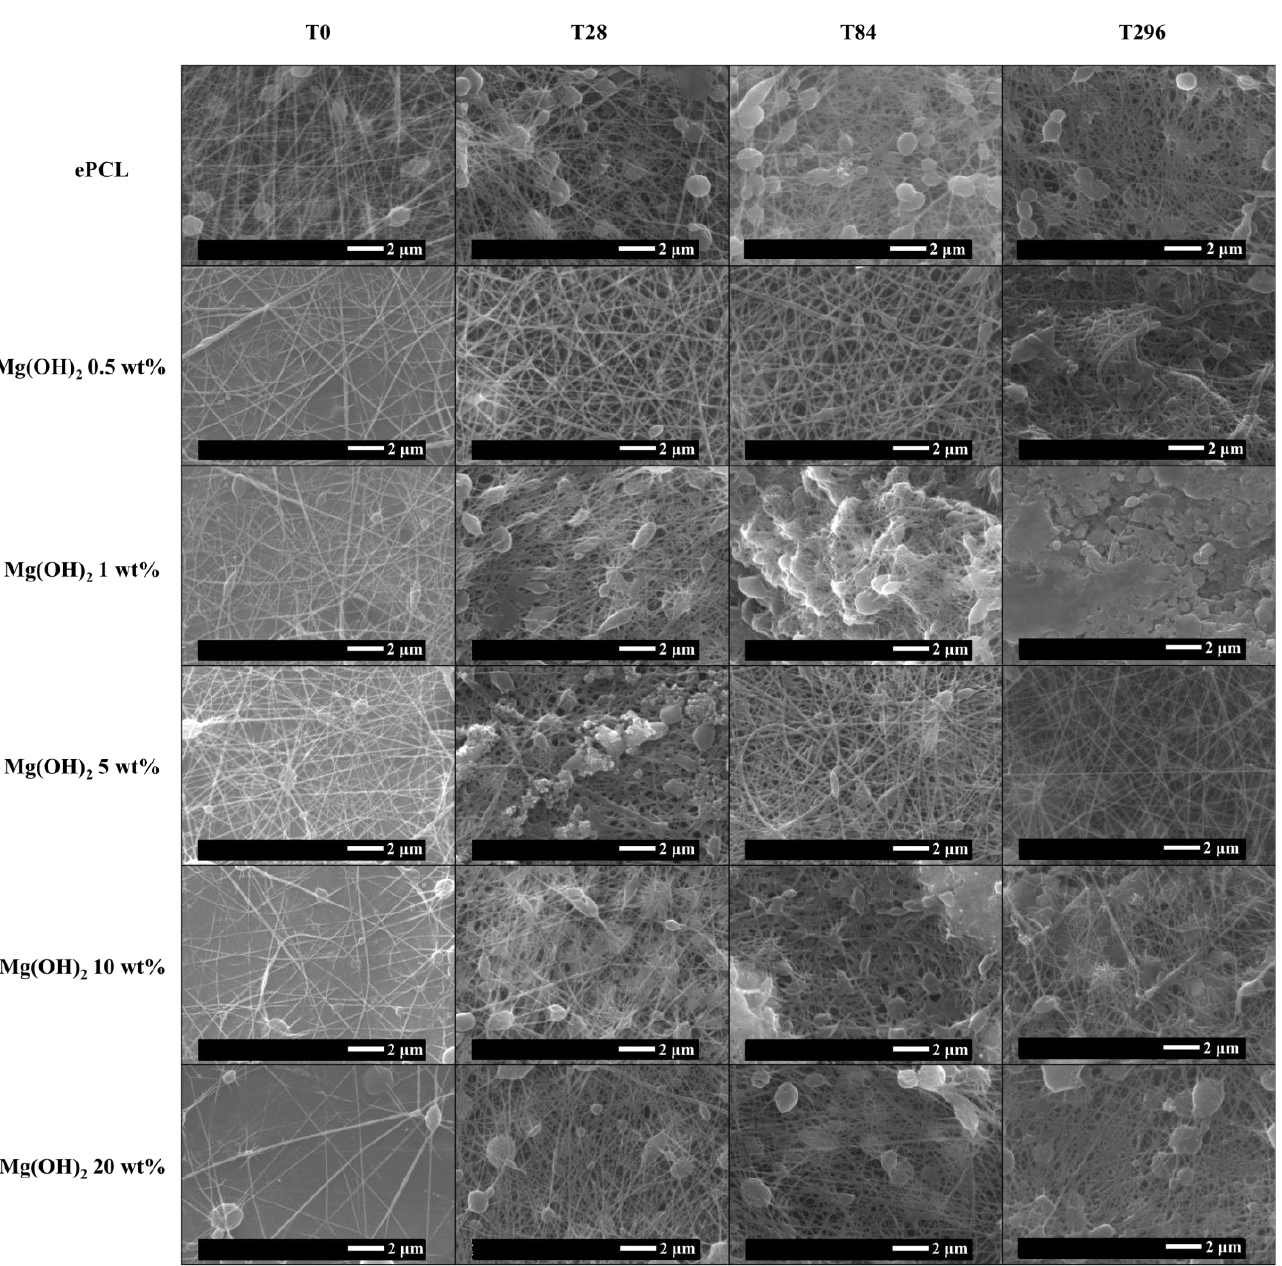
Figure 4. SEM images of ePCL and ePCL with Mg(OH) 2 at T0, T28 T84 and T296 in PBS